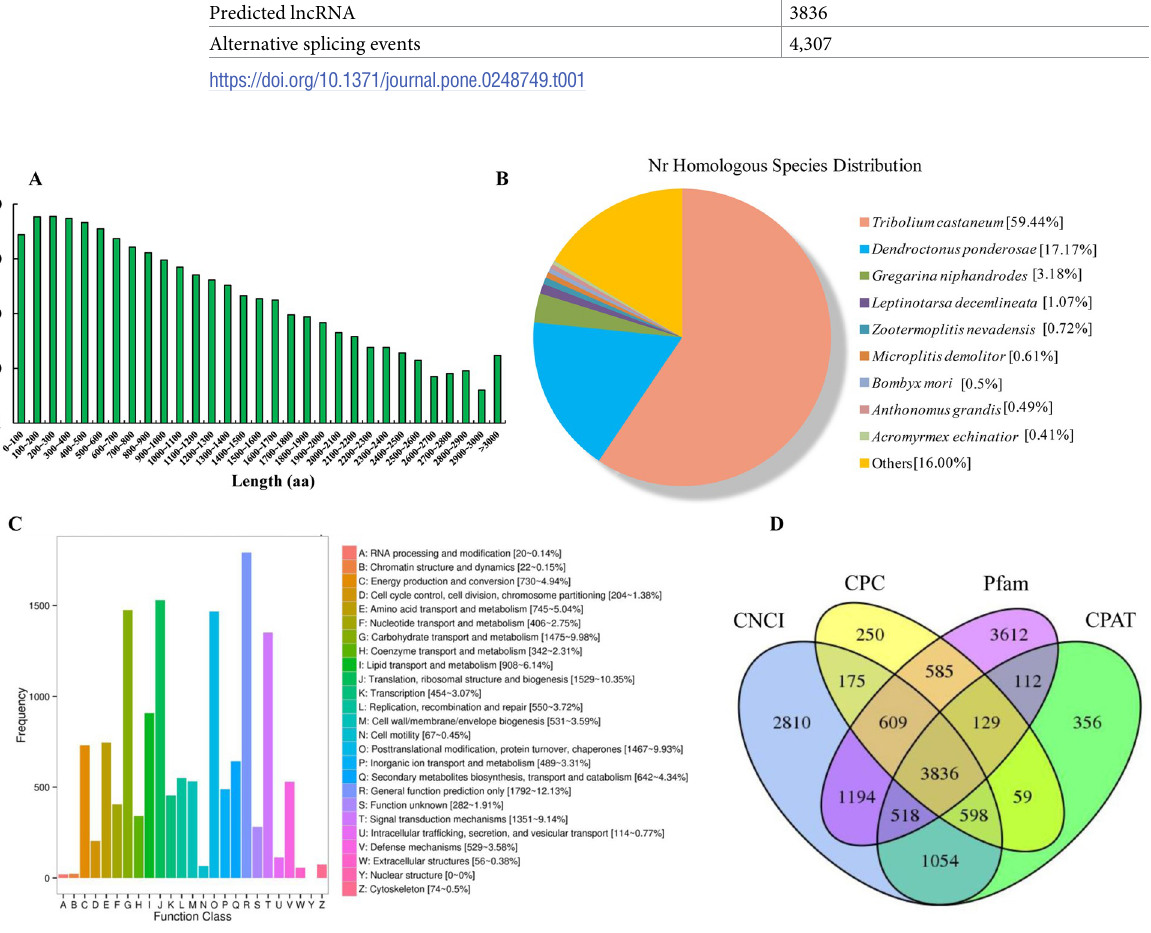
Fig 1. Basic information of full-length transcriptome analysis of Phyllotreta striolata . A. Length distribution of transcripts; B. homologous species distribution in Nr database; C. COG function classification of transcripts; D. lncRNA prediction results.